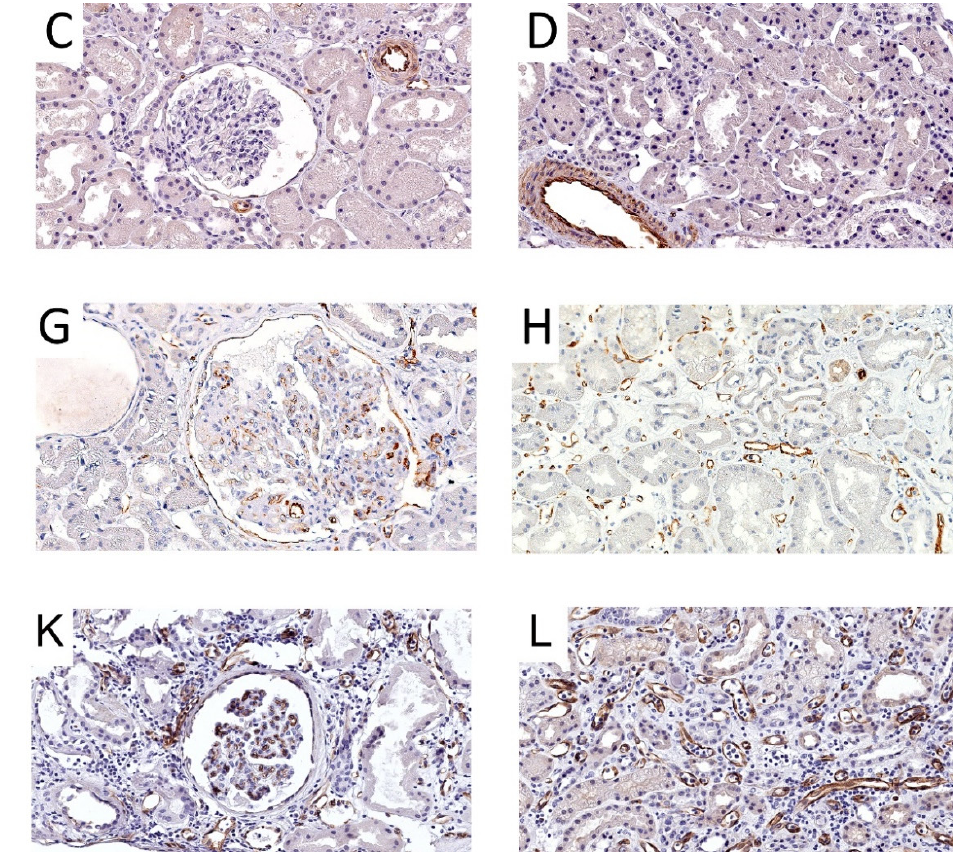
Figure 1. The control group ( A – D ) showed no morphological signs of rejection ( A ) and resulted negative to C4d ( B ) and Cav-1 IHC, the latter both in glomerular ( C ) and peritubular ( D ) capillaries. In Cav-1 IHC negative cases (Grade 0), arterial vessels were evaluated as on-slide positive controls ( C , D ). The c-ABMR group was composed of C4d positive ( E – H ) and C4d negative ( I – L ) cases, both presenting features of TG ( E , I ). The former group presented a positive C4d IHC in peritubular capillaries ( F ) and was then scored accordingly to the Banff classification. Accordingly, Cav-1 IHC showed a diffuse and intense positivity in glomerular ( G ) and peritubular ( H ) capillaries. Although showing TG features ( I ), C4d negative cases presented no expression of C4d ( J ). Conversely, Cav-1 maintained the positivity both in glomerular ( K ), where Cav-1 perfectly traced remodeled segments of basement membrane, and peritubular ( L ) capillaries, thus supporting the diagnosis of c-ABMR. Original magnification 300×.